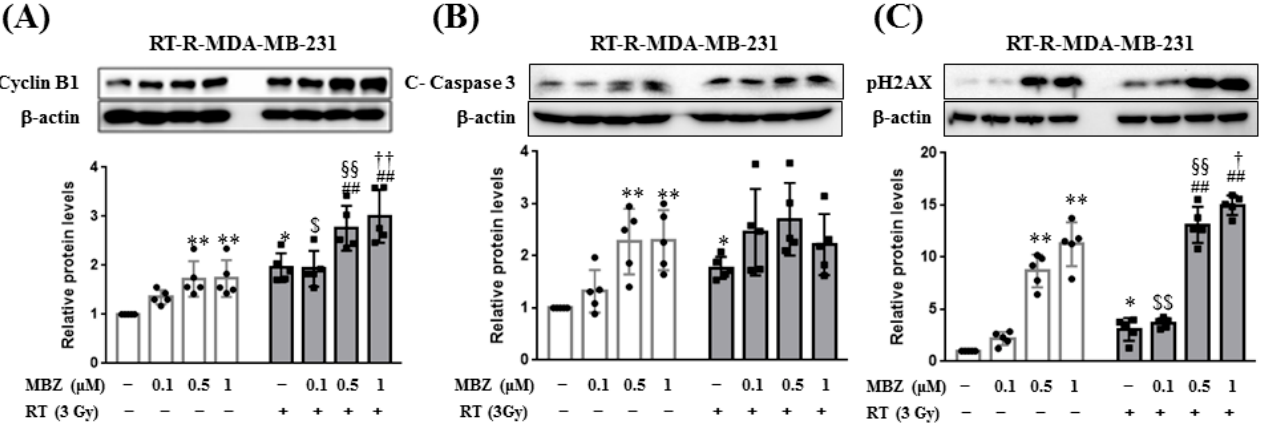
Figure 5. The combination of mebendazole (MBZ) and radiotherapy (RT) significantly induces cyclin B1 expression and the levels of the DNA damage marker, pH2AX, compared to RT. RT-resistant (RT-R)-MDA-MB-231 cells were treated with MBZ (0.1, 0.5, and 1 μ M) for 1 h and then irradiated with a 3 Gy dose of X-rays. After 24 h, the protein expression of ( A ) cyclin B1, ( B ) cleaved caspase-3, and ( C ) pH2AX were determined in cell lysates by western blotting as described in the Materials and Methods. The white bar graph represents the MBZ alone treatment group, and the gray bar graph represents the MBZ and radiotherapy combination group. The values are presented as the mean ± SD from five independent determinations (* p < 0.05, ** p < 0.01 compared with the control; ## p < 0.01 compared with the control of RT 3 Gy; $ p < 0.05, $$ p < 0.01 compared with MBZ (0.1 μ M); §§ p < 0.01 compared with MBZ (0.5 μ M); † p < 0.05, †† p < 0.01 compared with MBZ (1 μ M)).